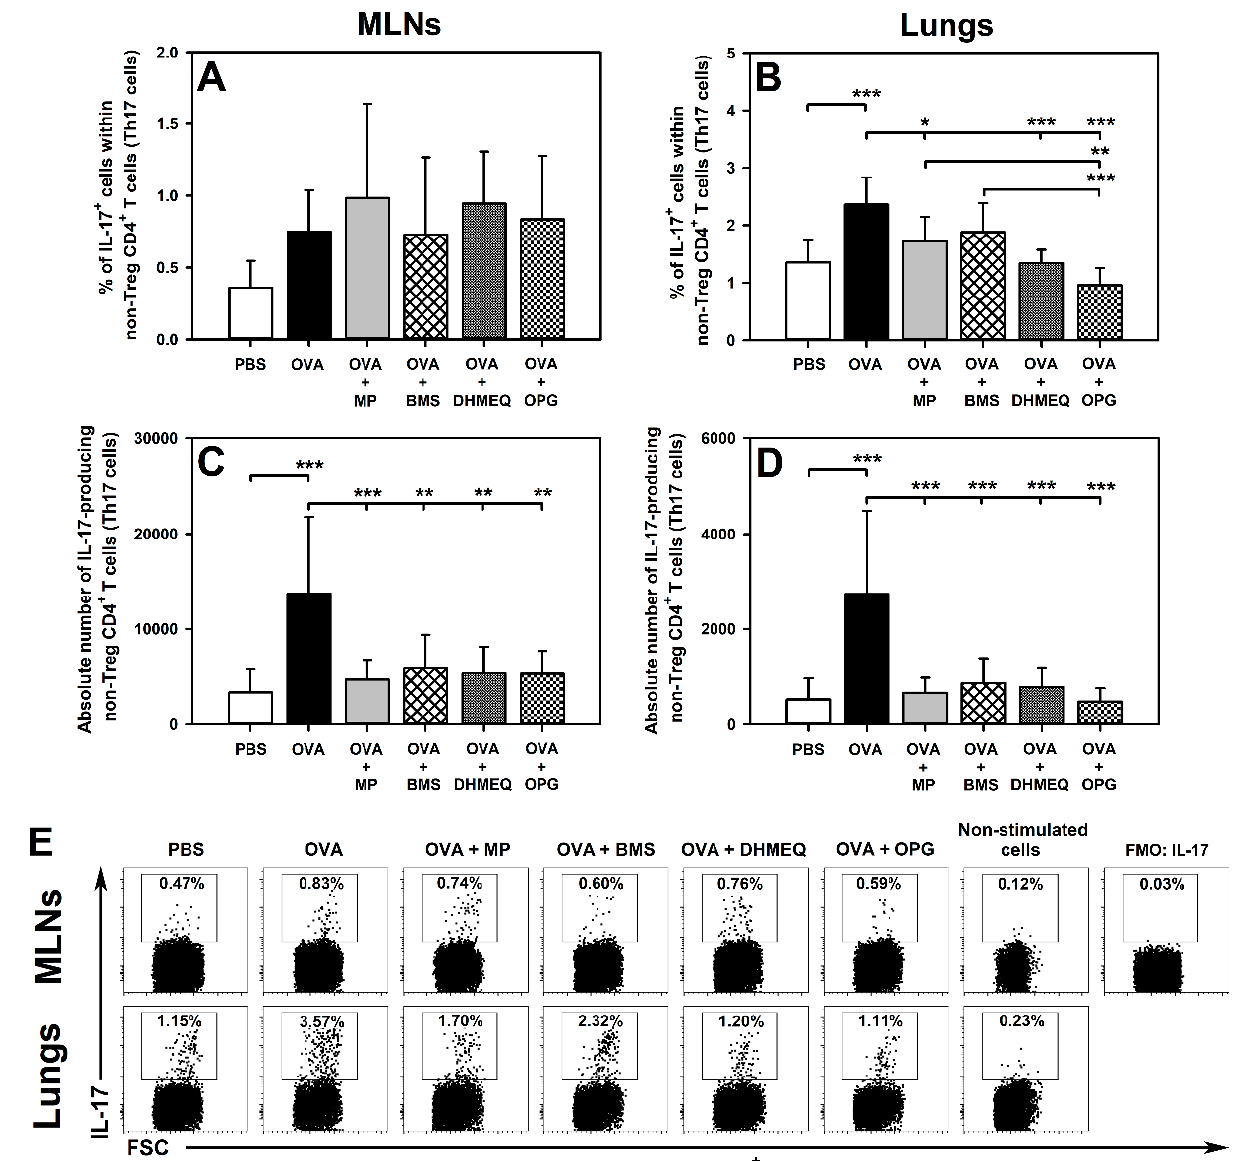
Figure 3. Effect of inhibitors of IKK (BMS-345541 (BMS)), NF- κ B translocation (dehydroxymethylepoxyquinomicin (DHMEQ)) and RANK/RANK-L interaction (osteoprotegerin (OPG)), and glucocorticosteroid (methylprednisolone (MP)) administration on the number of IL-17-producing non-Treg CD4 + T cells. The relative count ( A , B ) is expressed as a per- centage of IL-17-producing cells within non-Foxp3 + CD25 + CD4 + T cells. The absolute count ( C , D ) represents the number of IL-17-producing non-Foxp3 + CD25 + CD4 + T cells per MLN or lung sample collected from individual mice. * p < 0.05, ** p < 0.01, *** p < 0.001. Examples of dot plot cytograms showing the distribution of IL-17-producing and non-producing cells within non-Treg CD4 + T cells ( E ).